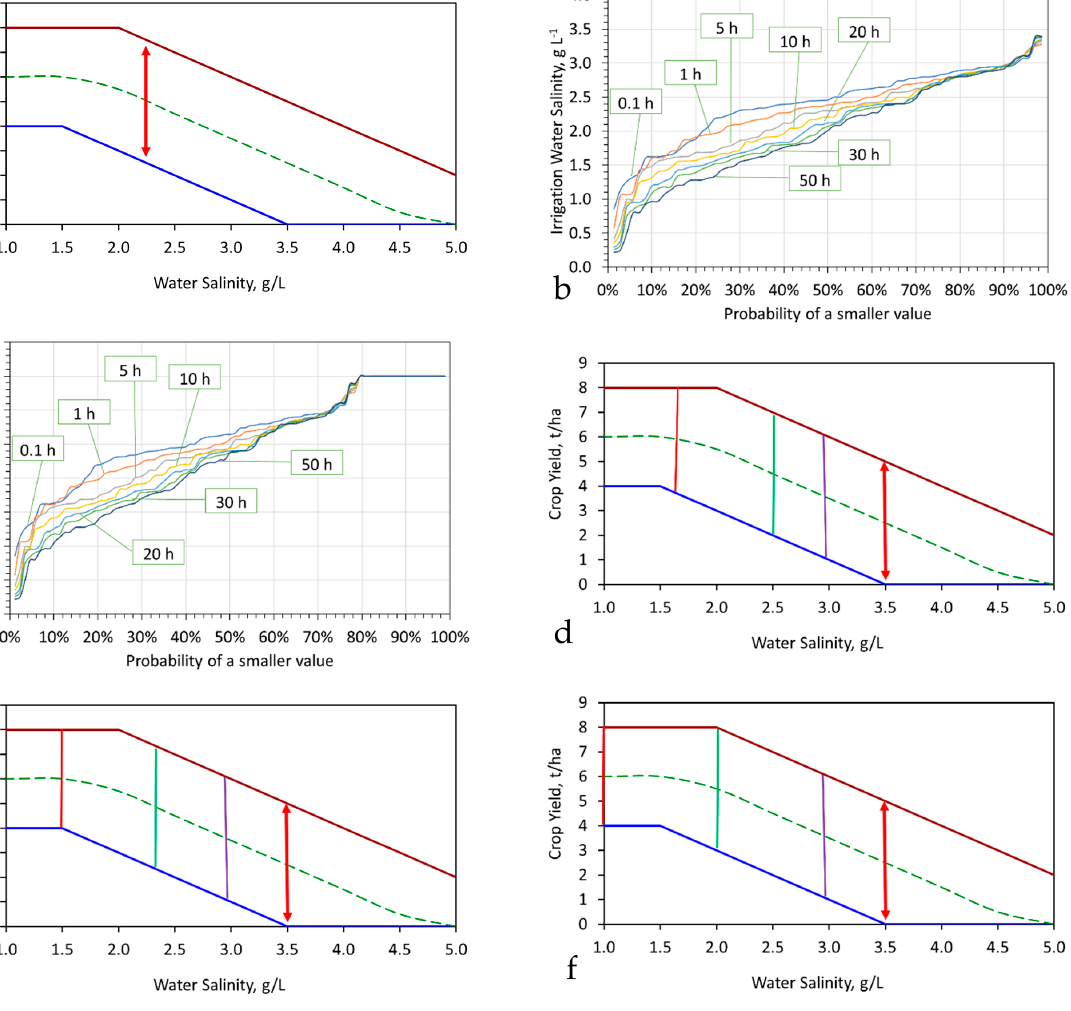
Figure 13. Impact of desalination on crop yield. ( a ), Expected relationship: green dotted line = median expectation; blue solid line = 90% probability of a higher yield; brown solid line = 90% probability of a lower yield. Red arrow = outcome range. ( b ), Expected irrigation water salinity distribution as a function of t r , and [b], if the feed water salinity is 3.5 g L − 1 and addition of the polymer to the water always results in desalination. h = hours. Data source: Figure 5, Table A5. ( c ), Expected irrigation water salinity distribution as a function of t r , and [c], if the feed water salinity is 3.5 g L − 1 and addition of the polymer to the water only results in desalination in 80% of water batches or volumes. Data source: Figure 5, Table A5. ( d ), Expected outcome range following desalination. t r , [c] = 0.1 h, addition of the polymer always results in desalination. Red arrow is outcome range without desalination. Vertical purple line = 90% probability of a lower water salinity; Vertical green line = 50% probability of a lower water salinity; Vertical red line = 10% probability of a lower water salinity. ( e ), Expected outcome range following desalination. t r , [c] = 5 h, addition of the polymer always results in desalination. Red arrow is outcome range without desalination. Vertical purple line = 90% probability of a lower water salinity; Vertical green line = 50% probability of a lower water salinity; Vertical red line = 10% probability of a lower water salinity. ( f ), Expected outcome range following desalination. t r , [c] = 50 h, addition of the polymer always results in desalination. Red arrow is outcome range without desalination. Vertical purple line = 90% probability of a lower water salinity; vertical green line = 50% probability of a lower water salinity; vertical red line = 10% probability of a lower water salinity.